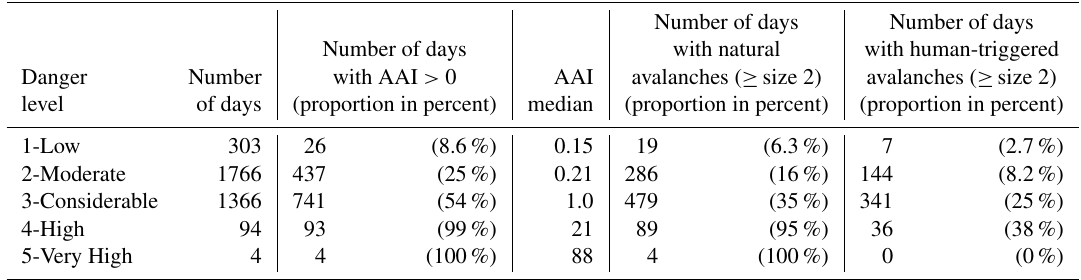
Table 2. Avalanche activity per danger level. The AAI considers all types of avalanches independent of snow conditions and trigger type; median value per day is given. Moreover, the number of days with either natural or human-triggered avalanches, at least size 2 or larger is shown. Number of days Number of days Number of days with natural with human-triggered Number with AAI > 0 AAI avalanches ( ≥ size